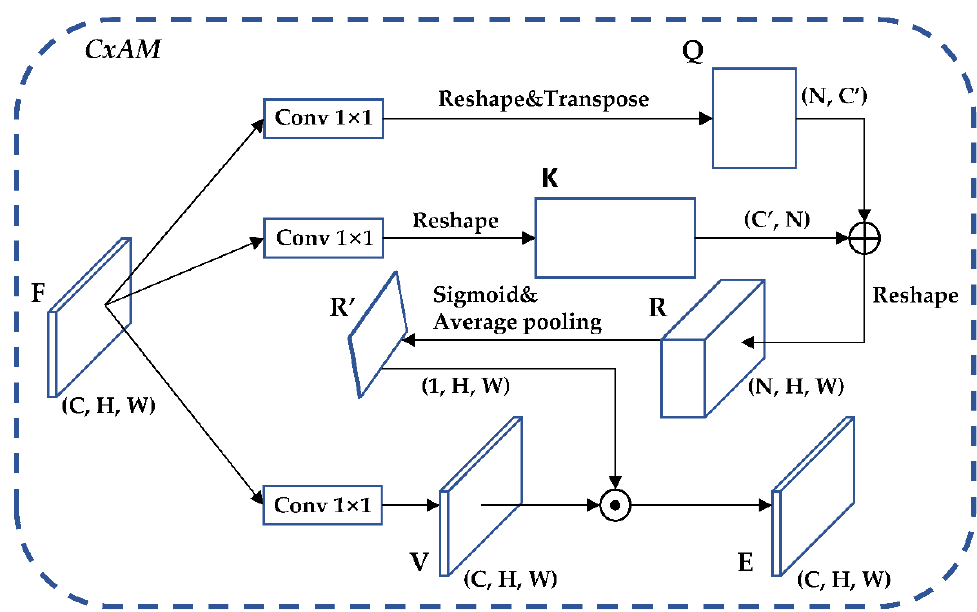
Figure 9. CxAM structure diagram.